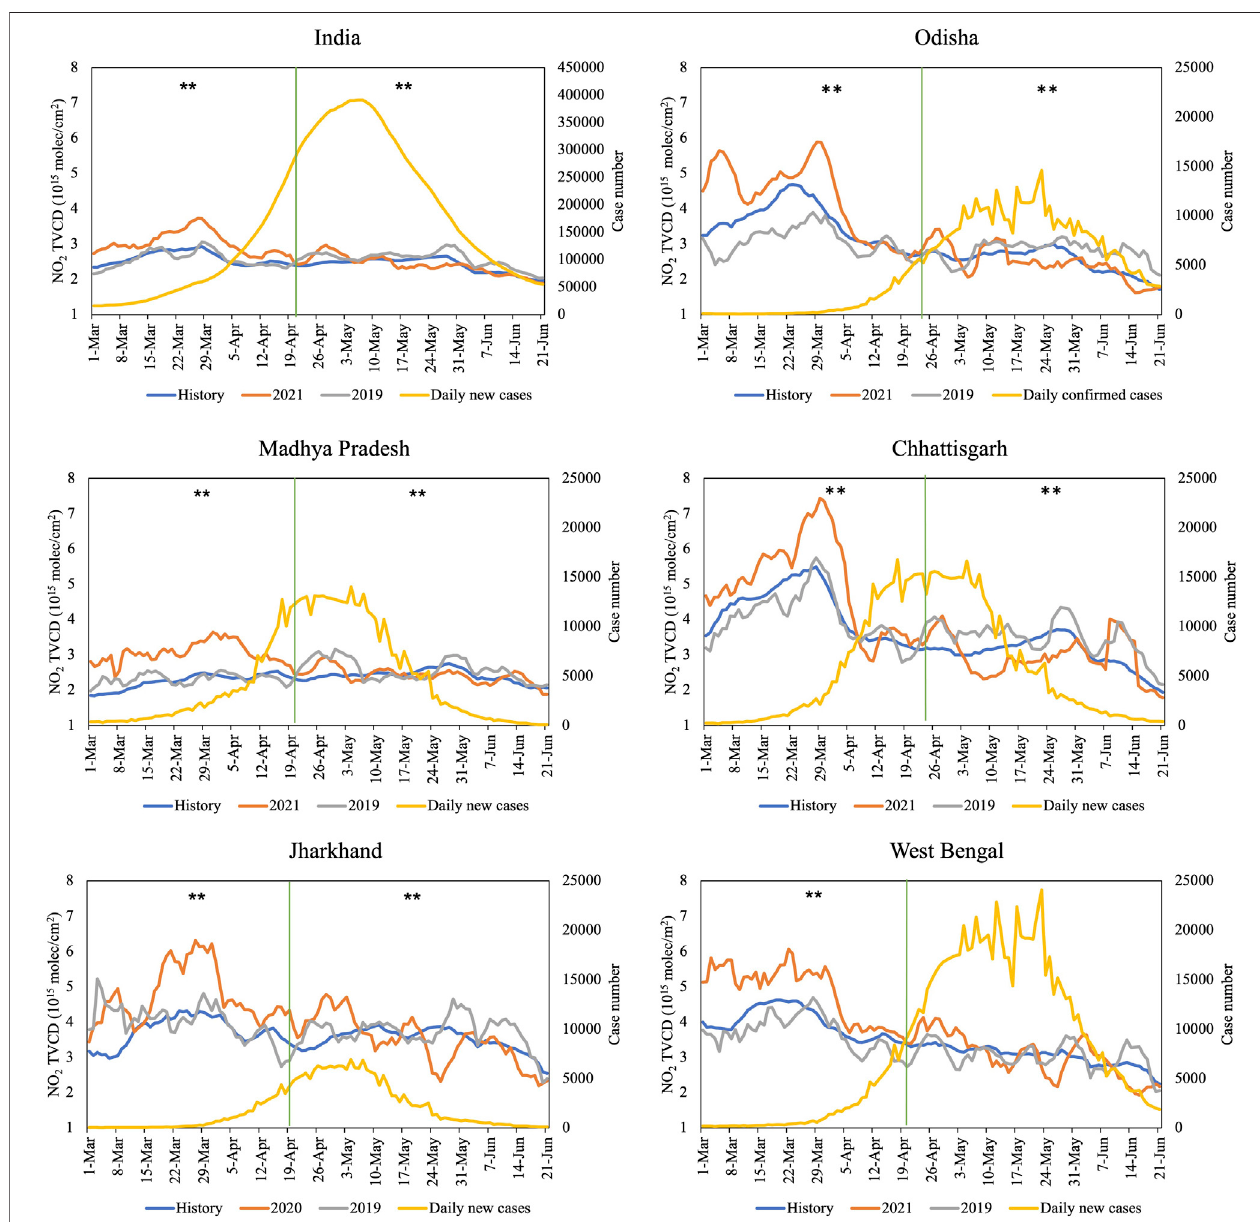
FIGURE 4 | Seven-day moving averages of NO 2 TVCD and daily new cases of COVID-19 over India and industrial states for 10-years mean (history), 2021 and 2019. ** indicates signi fi cant difference between 2021 and 2019 timeseries for each period at the 0.01 level (bilateral), and * indicates signi fi cant difference at the 0.05 level (bilateral). Points represent the midpoint of the 7-days interval. The vertical green-line indicates the start of the re-lockdown.